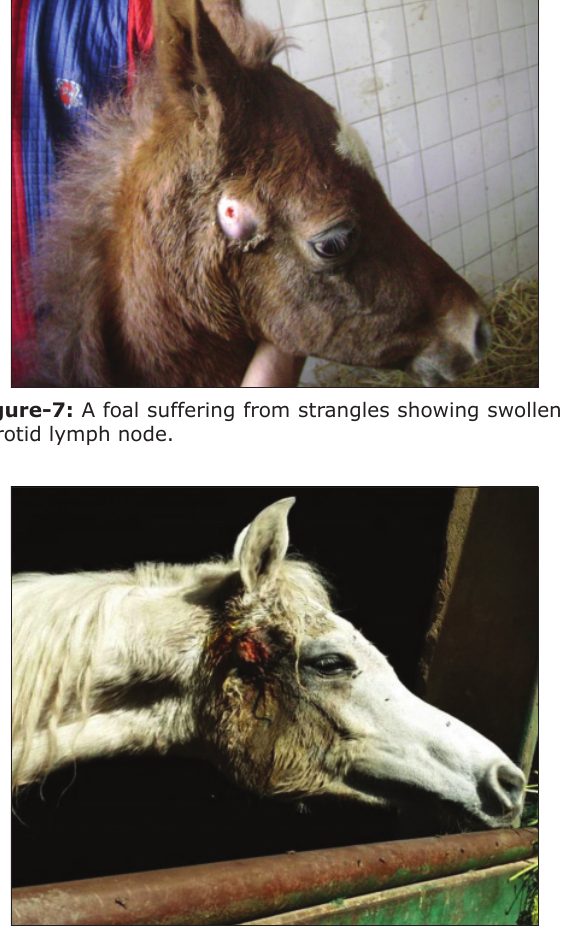
Figure-8: Swollen parotid lymph node with guttural pouch empyema in strangled horse.